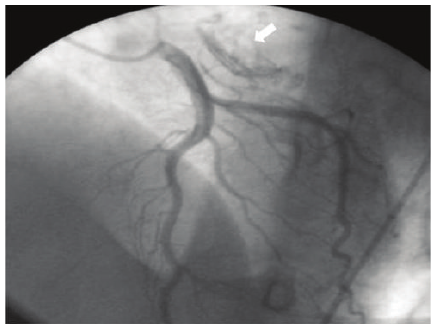
Figure 4: Angiographic coronary showing the neovascularization and the fistula.